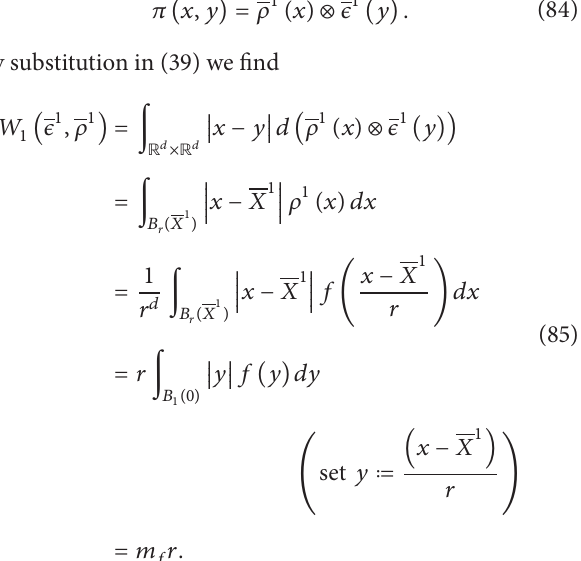
coefficients 𝛼 𝑗 (𝑥) (cf. Figure 6). The measure 𝜋 is generally not a transference plan between 𝜖 not guaranteed to have marginal 𝜖